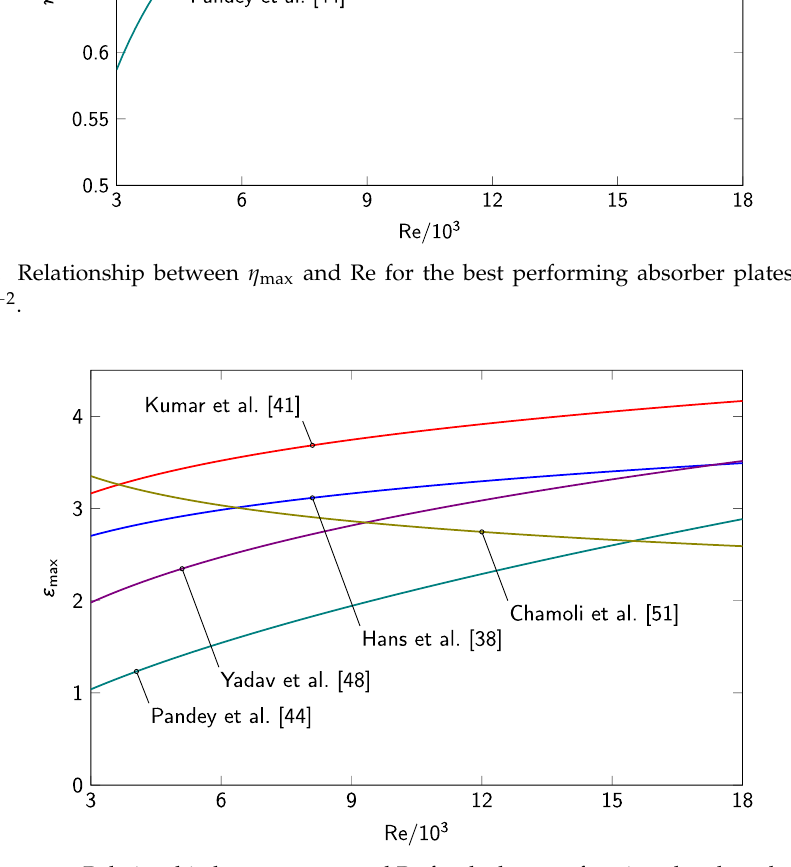
Figure 23. Relationship between ε max and Re for the best performing absorber